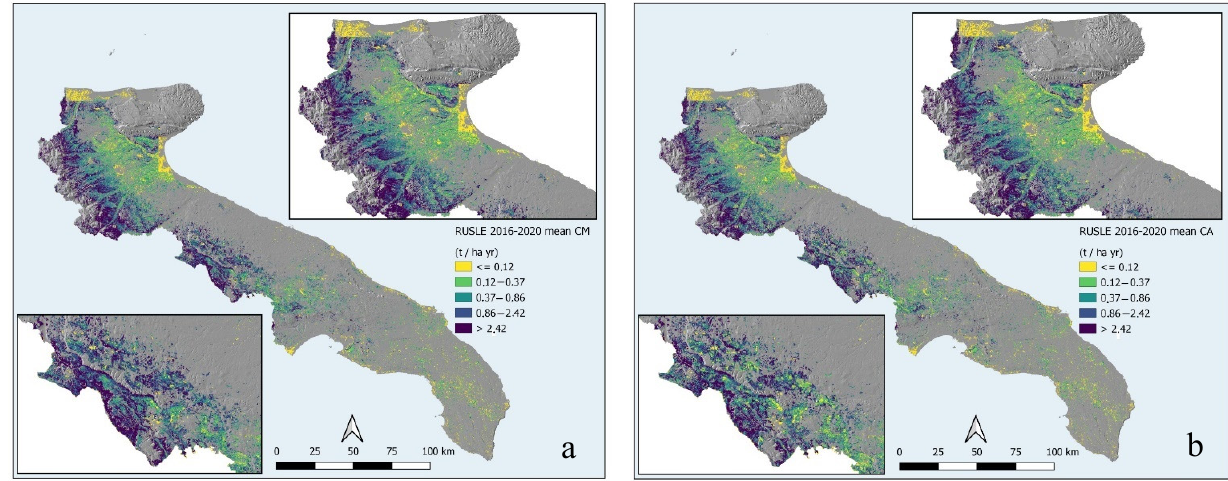
Figure 10. RUSLE model average maps (2016–2020) in Apulia region under ( a ) conventional management and ( b ) conservation agriculture for annual cropland.